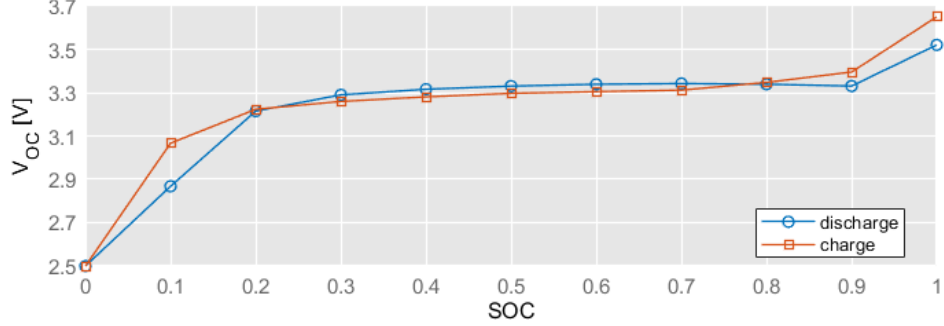
Figure 6. Open circuit voltage V OC test results.